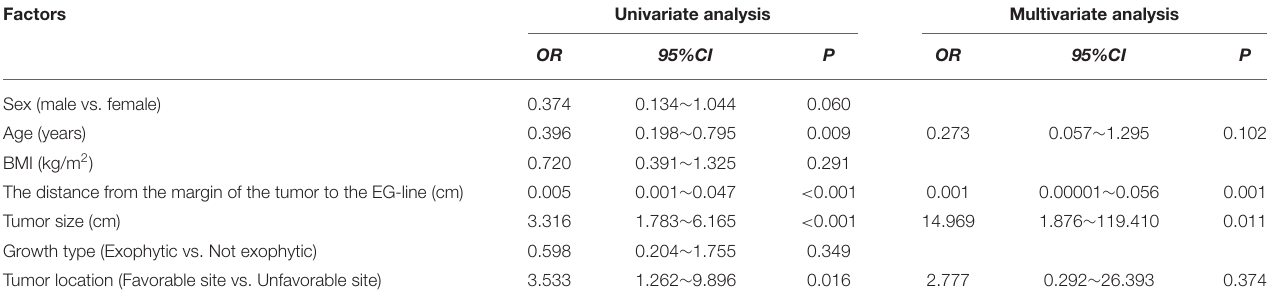
TABLE 2 | Analyses of the risk of the cardia excision on laparoscopic surgery for EGJ-GISTs. Factors Univariate analysis Multivariate analysis OR